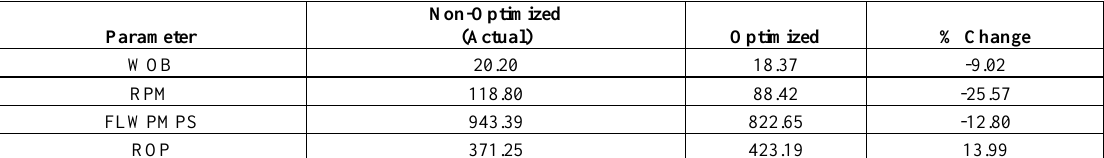
Table 6. Percentage decrease in operational parameters to achieve increased ROP